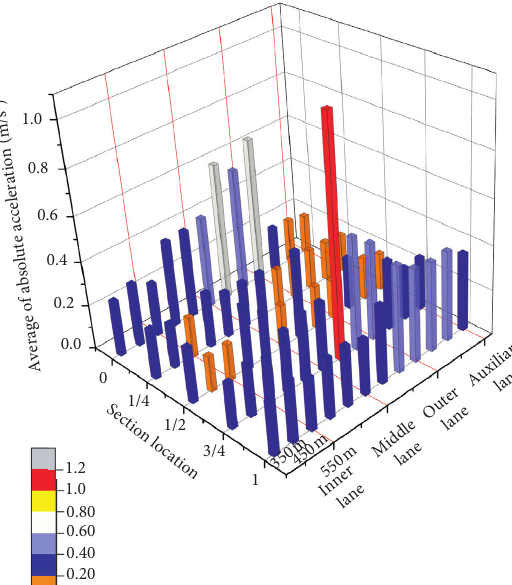
Figure 5: Acceleration of average absolute value analysis.